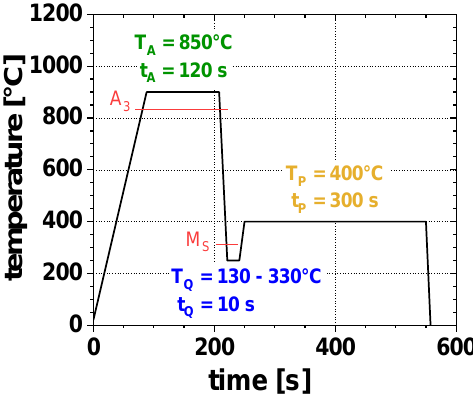
Figure 1. Schematic representation of the applied Quenching and Partitioning (Q&P) heat-treatment cycles for the investigated steels.